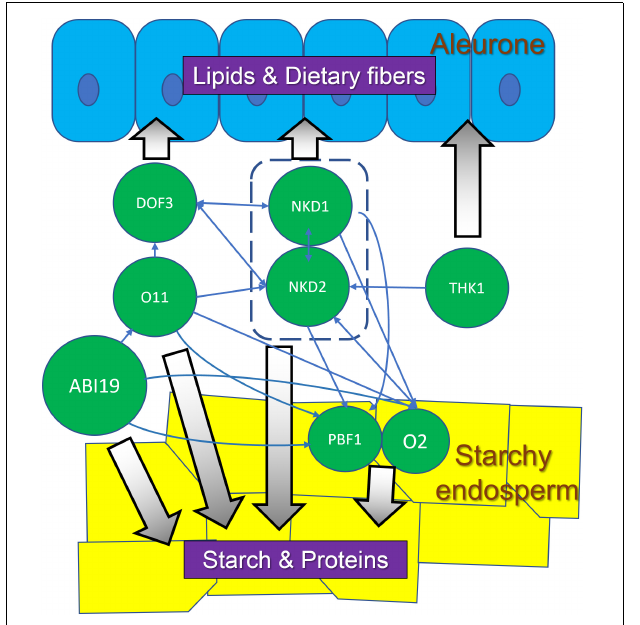
FIGURE 3 | Regulatory interactions among TFs in aleurone and SE, and their potential association with corresponding nutrient compounds. These TFs and associated pathways could be targets for bioengineering to optimize maize seed quality.